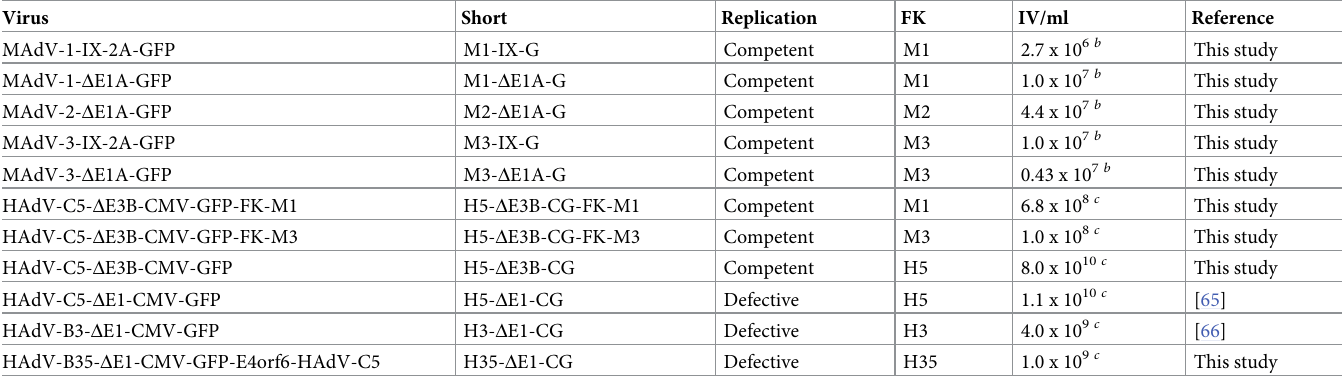
Table 1. Recombinant adenoviruses used in this study.